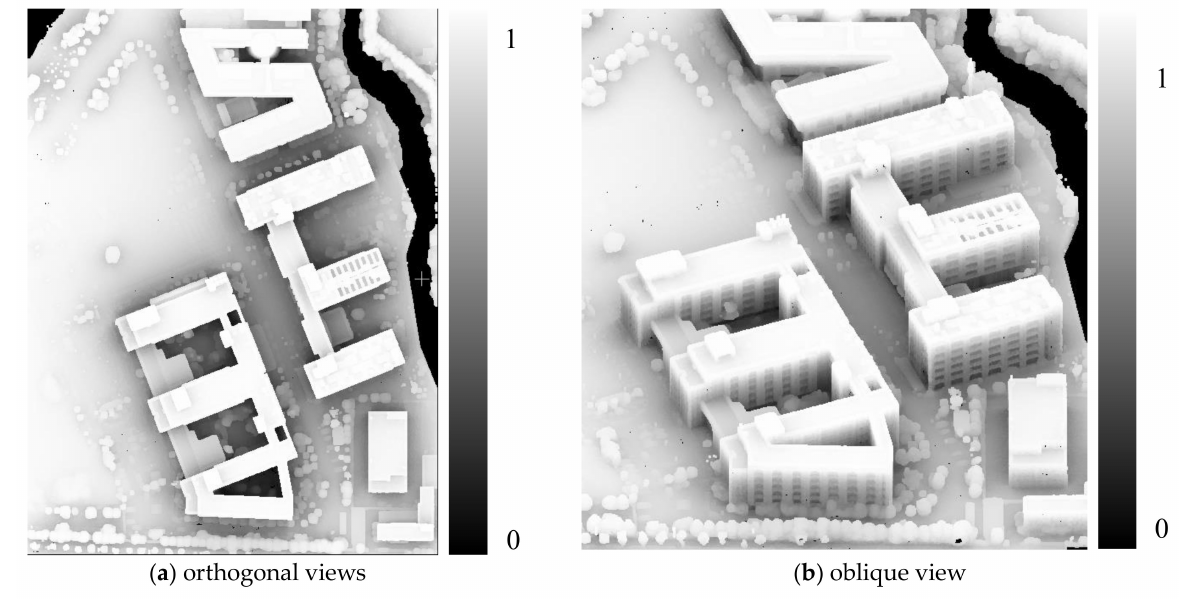
Figure 9. The calculated results of SVF.